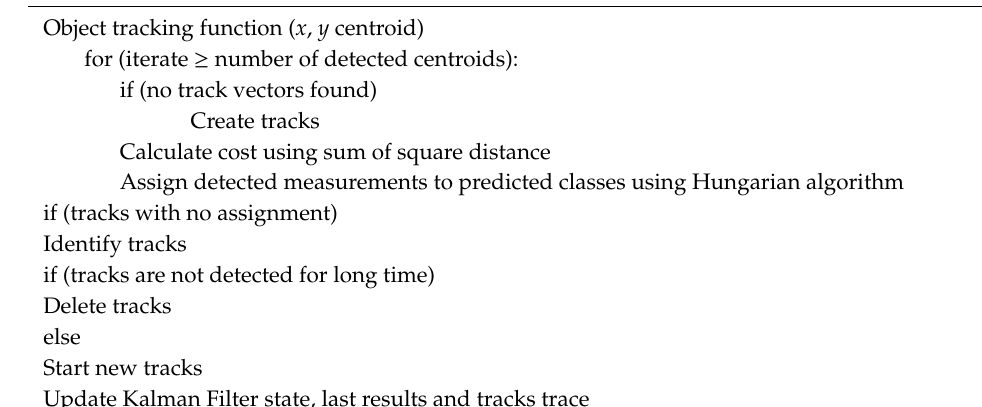
Algorithm 1. Pseudo-code for Kalman filter tracker.